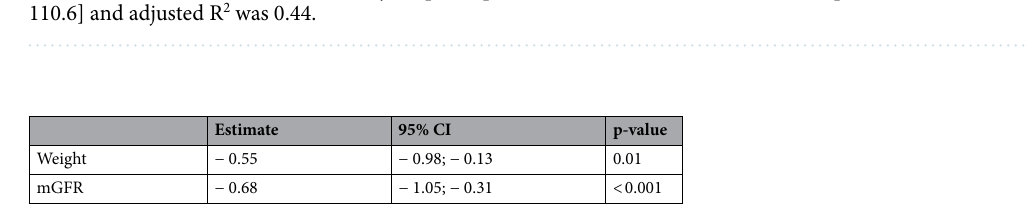
Table 4. Multivariable model summary for mGFR slope. For this model, intercept was 82.2 [27.4–137.0] and adjusted R 2 was 0.34.